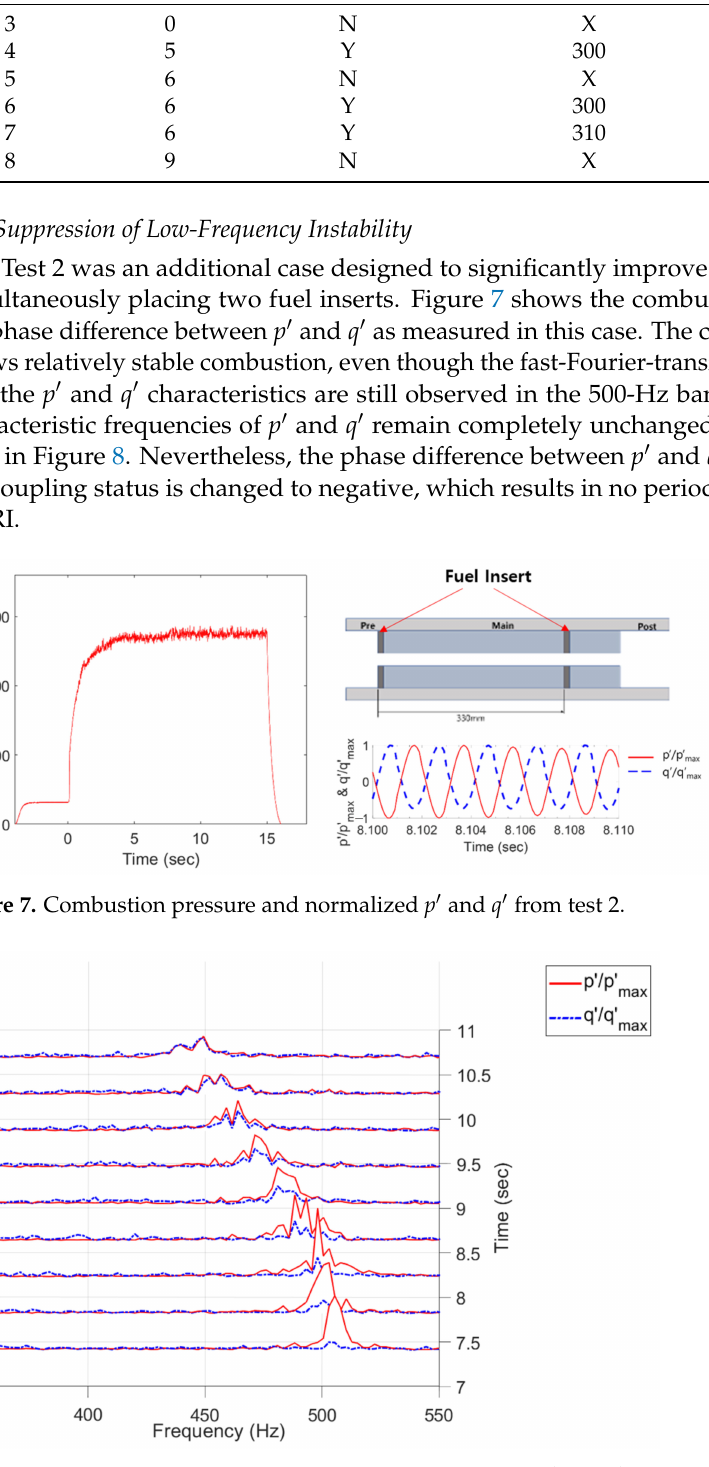
Figure 8. Temporal shift in frequency peaks for normalized p (cid:48) and q (cid:48) from test